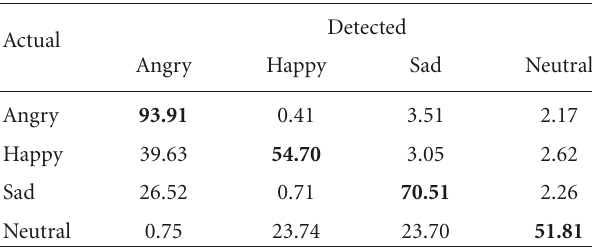
Table 6: Four emotions recognition rate (%) balanced speaker and text independent test-utterance based: 100 utterances per emotion, random sequence of speakers, SNR = 30 dB.